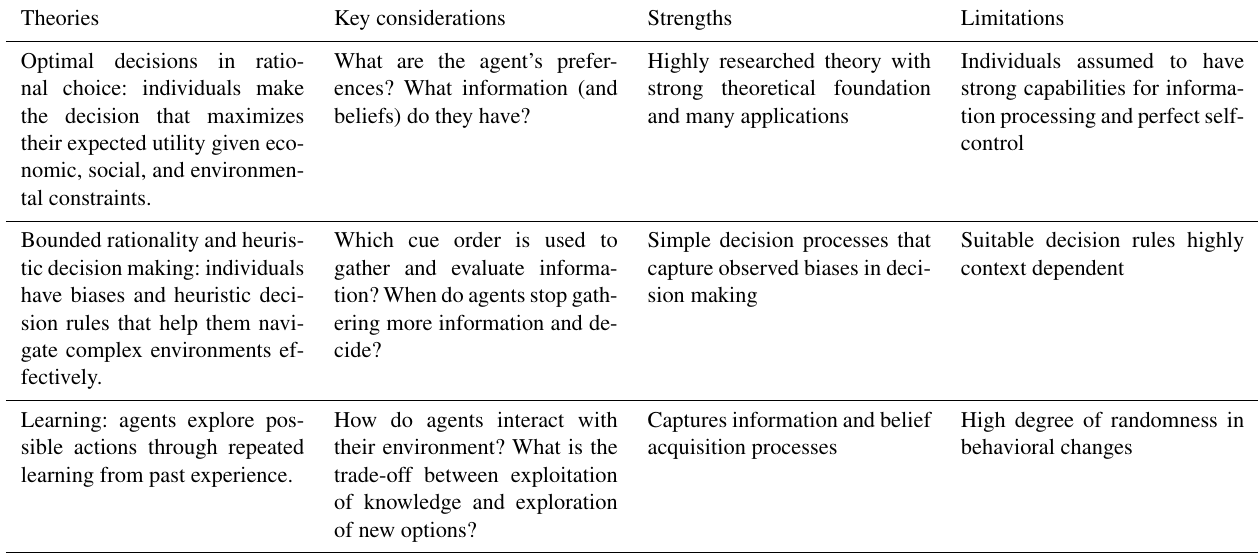
Table 2. Summary table for individual behavior and decision making. Theories Key considerations Strengths Limitations Individuals assumed to have Highly researched theory with What are the agent’s prefer- strong capabilities for informa- strong theoretical foundation ences? What information (and tion processing and perfect self- and many applications beliefs) do they have?